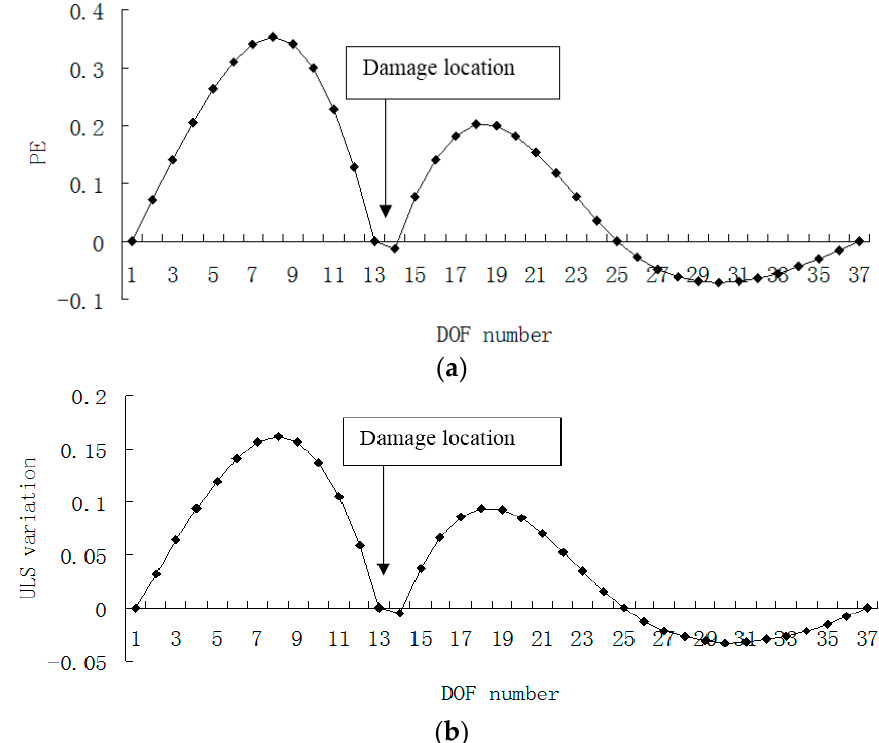
Figure 7. ( a ) Damage index (PE) map using the first four exact modes when the defect occurred in element 13; ( b ) Damage index (ULS variation) map using the first four exact modes when the defect occurred in element 13(×10 − 4 ).